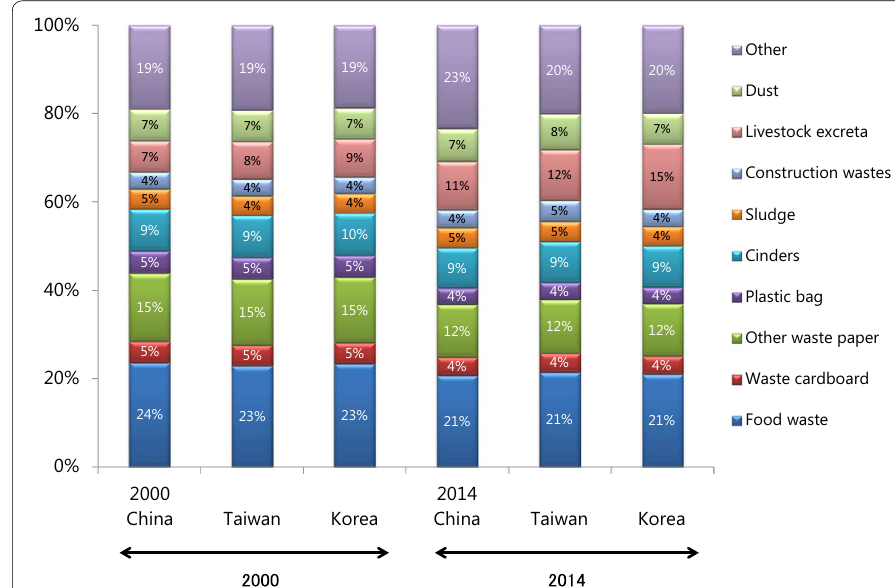
Fig. 4 Repercussion effects of visitor’s consumption on waste generation by waste category